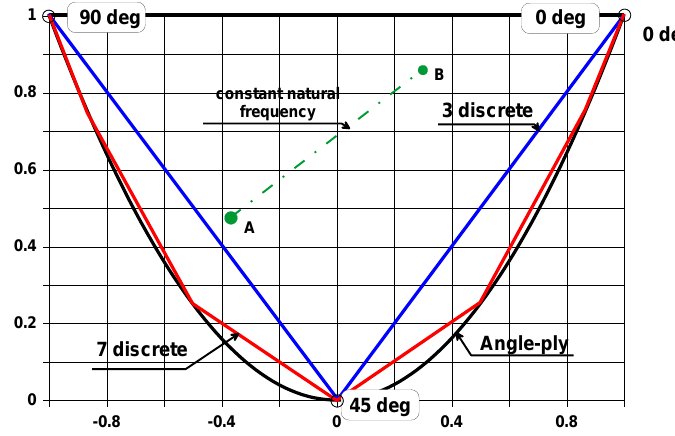
Figure 4. The design space for continuous and discrete design variables.